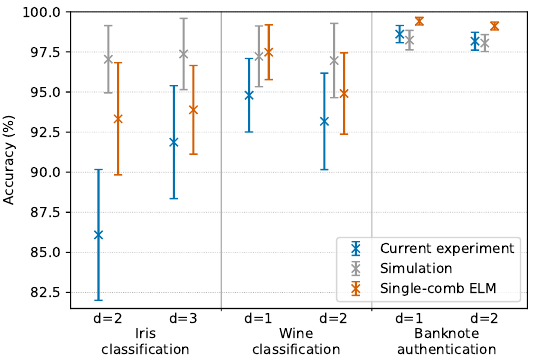
Figure 3. Results of parallel operations mode tests. d indicates the number of consecutive comb lines on which each feature is encoded. The same task types with different d values are executed in parallel on two different combs. Each result is compared with the numerical simulation and previous experiments of a single-comb ELM [19]. Error bars represent the standard deviation of the score over 100 random repartitions of training and testing data (more information in Section